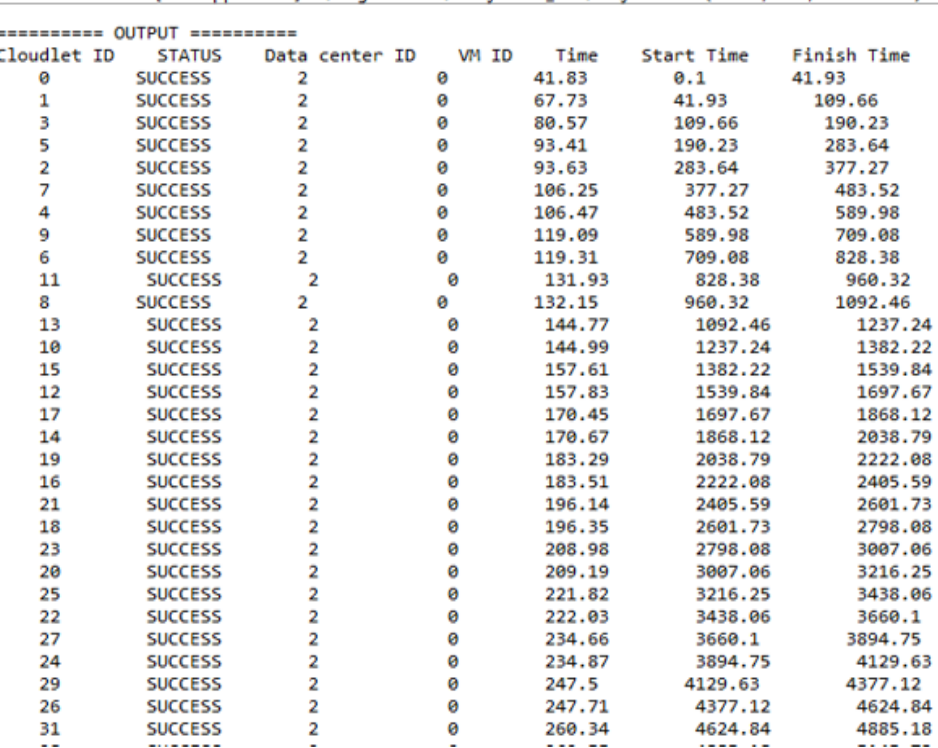
Figure 8. Experimental result in term of execution time for scheduling non safety